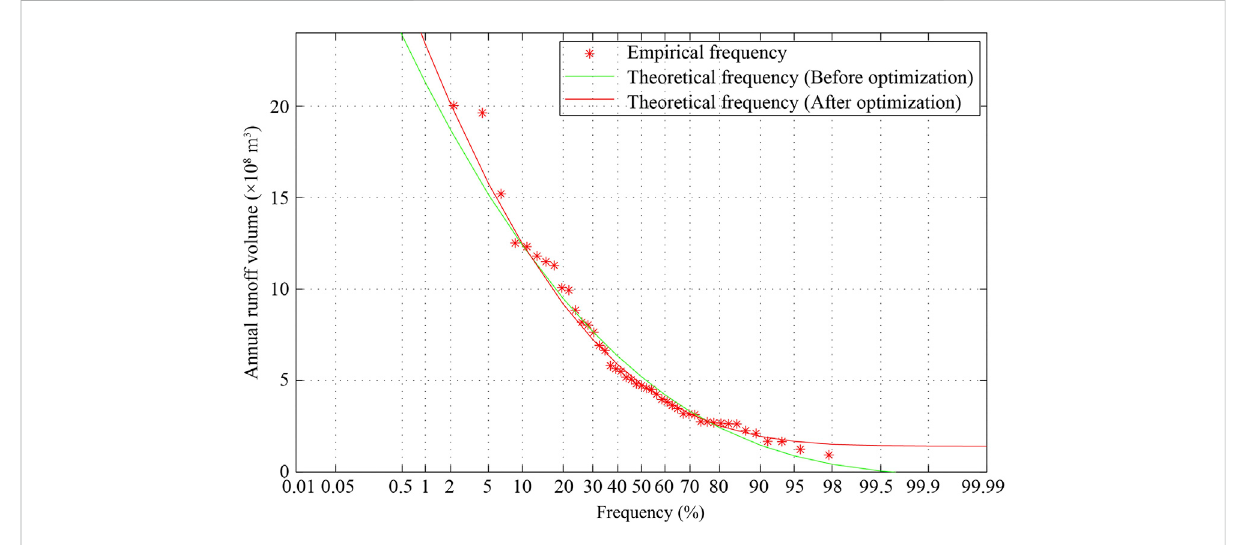
FIGURE 8 Annual runoff frequency curve of Wangkuai